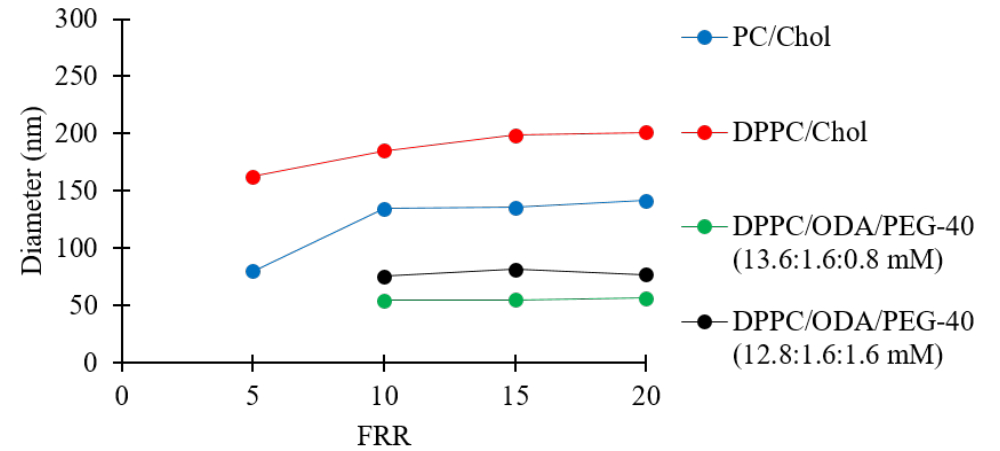
Figure 8. Z-average sizes of liposomes consisting of di ff erent lipid formulations. Data represent the means of three measurements with corresponding standard deviations. Refer to Table 1 (batch codes #22 PC, #20 PC, #23 PC, #24 PC, #27 DPPC, #28 DPPC, #29 DPPC, #30 DPPC #40 DPPC, #41 DPPC, #42 DPPC, #43 DPPC, #44 DPPC, #45 DPPC) for the corresponding experimental conditions, lipid compositions, and numerical data of mean values and standard